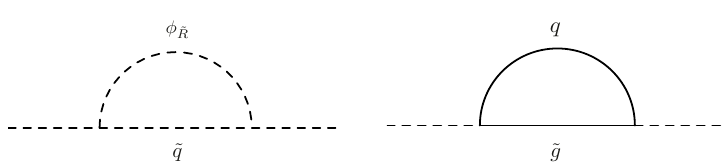
Figure 4 . Gaugino mediated masses of the squark (cid:12)elds. The purely scalar loop cancels the logarithmic divergence which appears in the prototypical gaugino mediated correction to squark